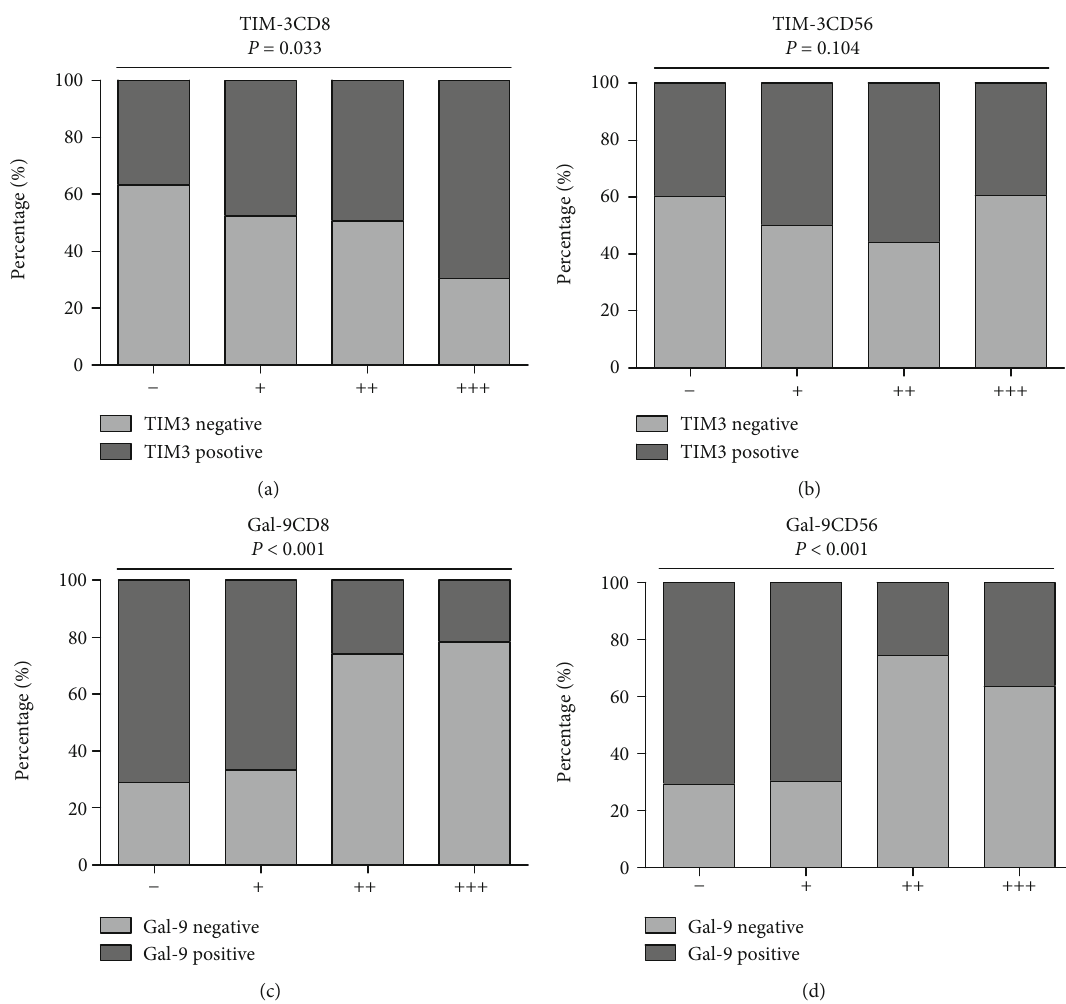
Figure 5: Distribution correlation among various TIL subsets. (a) The higher the densities of CD8 + T cells, the more TIM-3 expression was presented. (b) No signi fi cant correlation was presented between TIM-3 expression and CD56 distribution. (c, d) The lower the degrees of CD8 (c) and CD56 (d), the more Gal-9 expression was